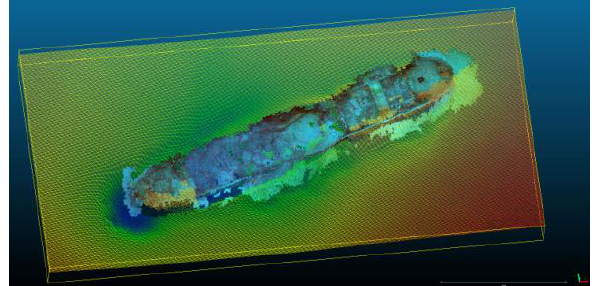
Figure 11: Merging optic and acoustic 3D point cloud using ICP algorithm in CloudCompare